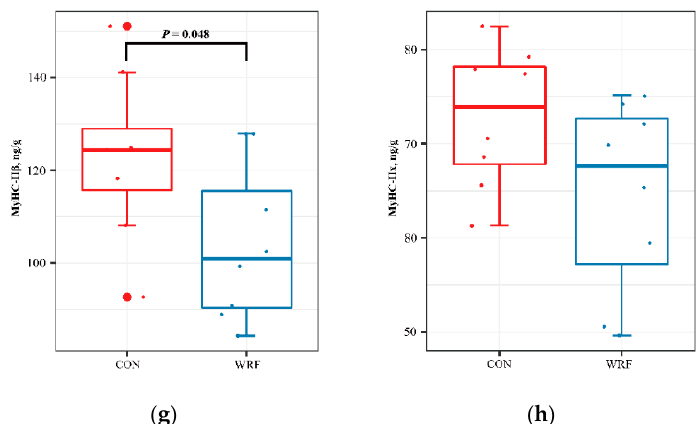
Figure 3. Effects of dietary fungal-treated corn straw on myosin heavy-chain (MyHC) content in longissimus thoracis et lumborum (LTL) and semimembranosus (SM) muscles of lambs infected with gastrointestinal nematodes. ( a ) MyHC-I content in LTL muscle of CON and WRF lambs; ( b ) MyHC-II α content in LTL muscle of CON and WRF lambs; ( c ) MyHC-II β content in LTL muscle of CON and WRF lambs; ( d ) MyHC-IIx content in LTL muscle of CON and WRF lambs; ( e ) MyHC-I content in SM muscle of CON and WRF lambs; ( f ) MyHC-II α content in SM muscle of CON and WRF lambs; ( g ) MyHC-II β content in SM muscle of CON and WRF lambs; ( h ) MyHC-IIx content in SM muscle of CON and WRF lambs; Within a box-plot, p value was given to declare significance which p < 0.05 means differ.